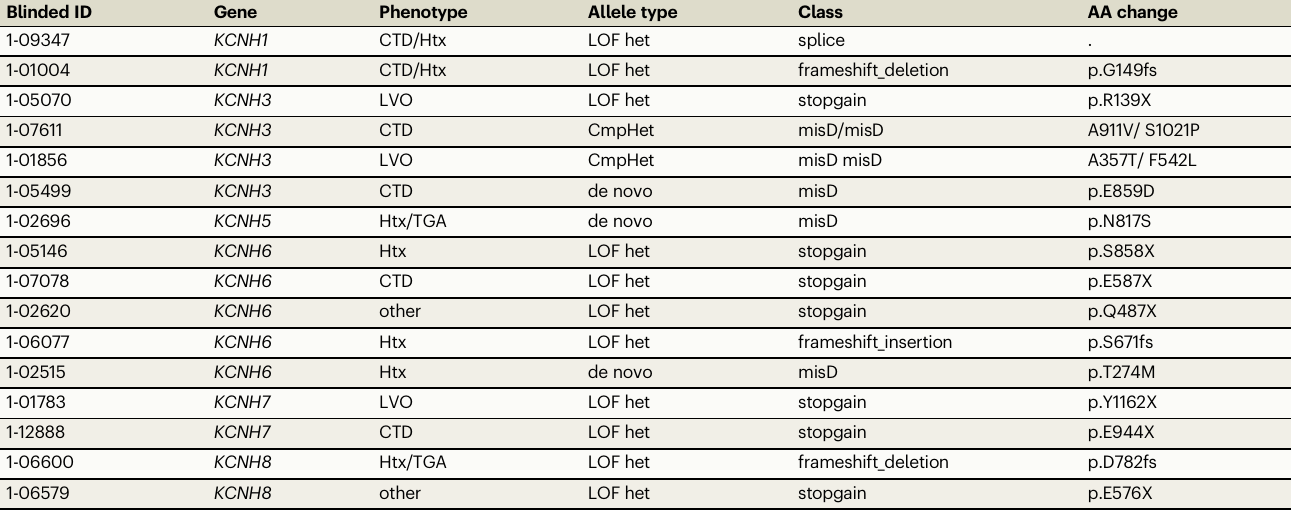
Table 1 | KCNH gene variants identi fi ed in patients with CHD Blinded